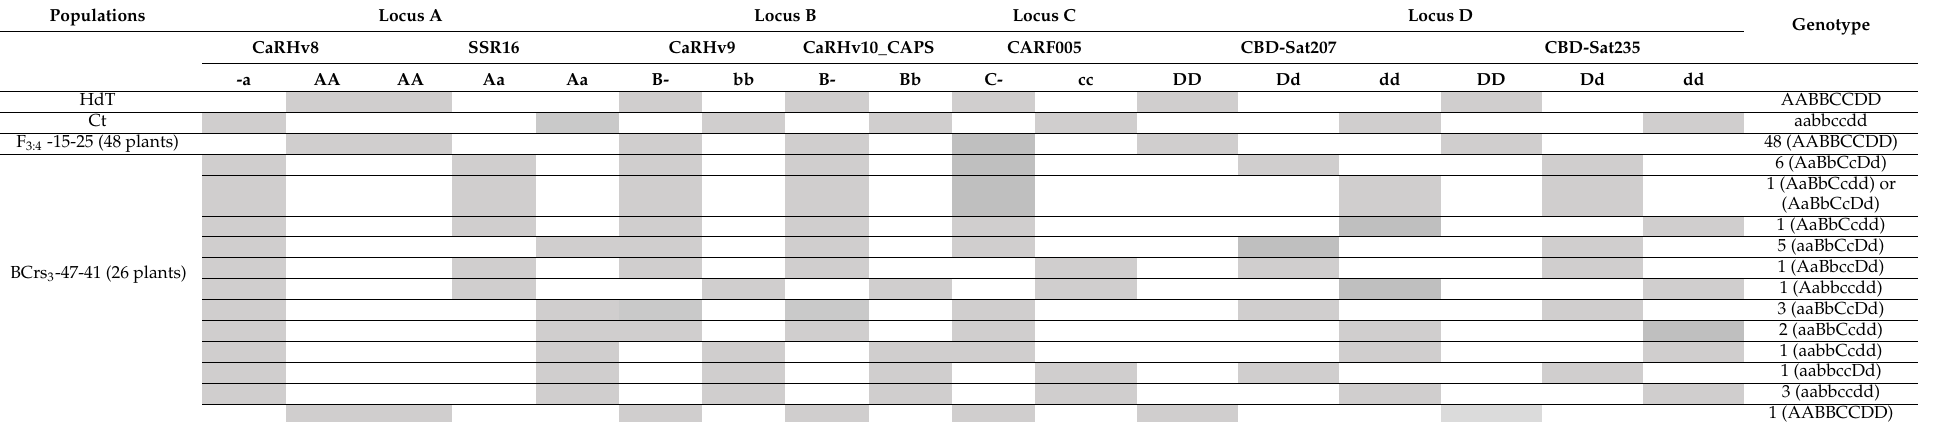
Table 3. Genotypic data of theF 3:4 -15-25 and the BCrs 3 -47-41 progenies obtained by SAM aiming to pyramid the allele for resistance to CLR and